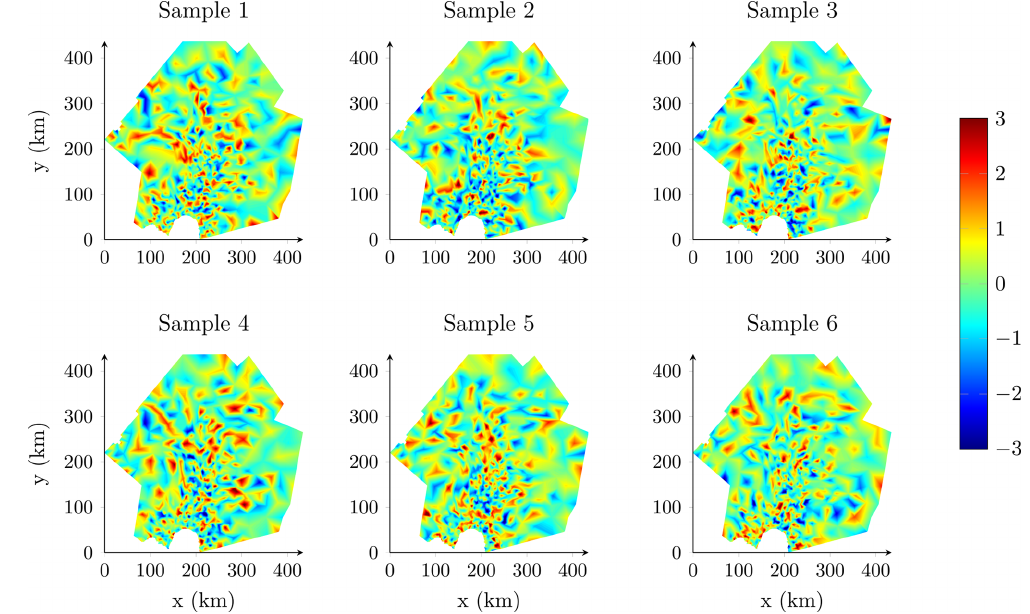
Figure 6. Samples of the random perturbation p q ( s ) over Pine Island Glacier with a parameter range of 10km.